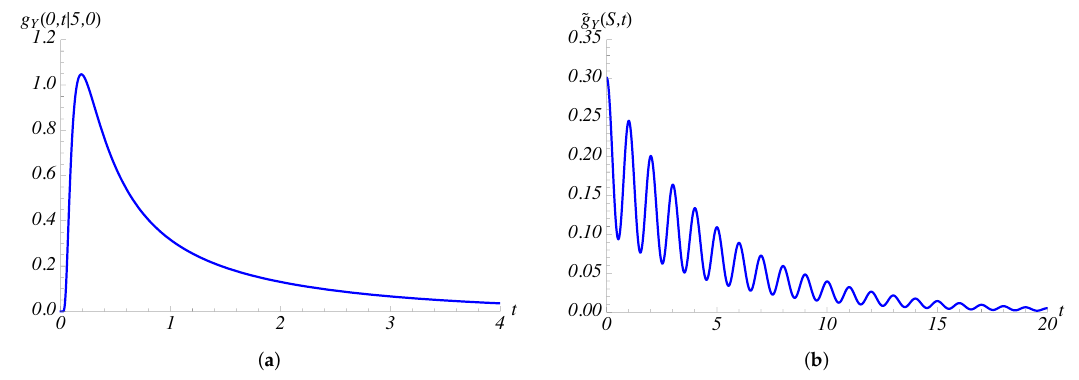
Figure 9. The FPT density (51) is plotted on the left for the same choices as Figure 6 with x 0 = 5. The asymptotic behavior (cid:101) g Y ( S , t ) of the FPT density g Y ( S , t | x 0 , t 0 ) is shown on the right, given in (62), with S = 20 and x 0 < S . ( a ) σ 2 = 2; ( b ) σ 2 = 2.